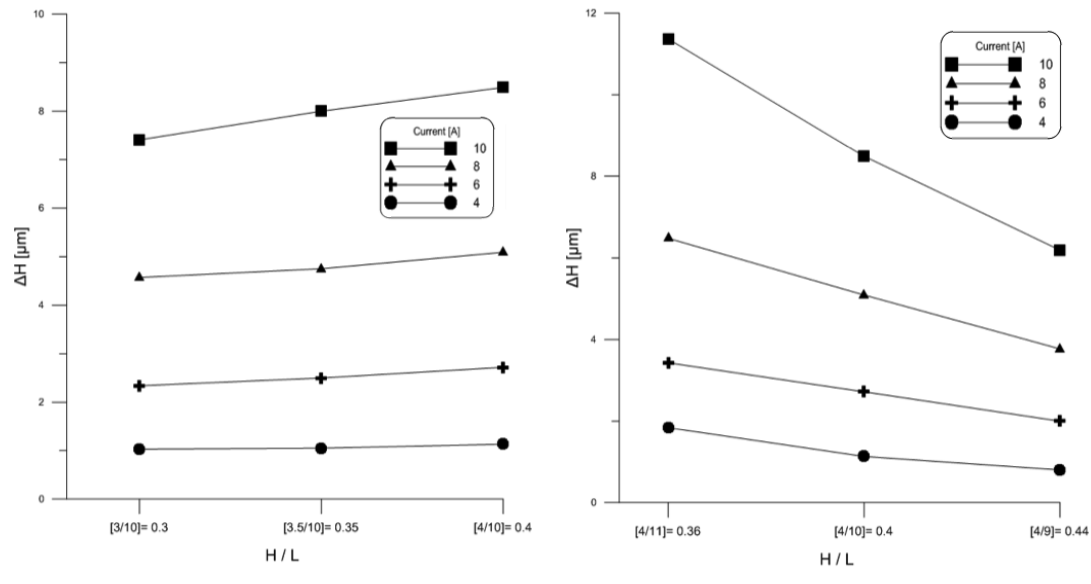
Figure 8. Impact of aspect ratio on Al wire flexure under dc